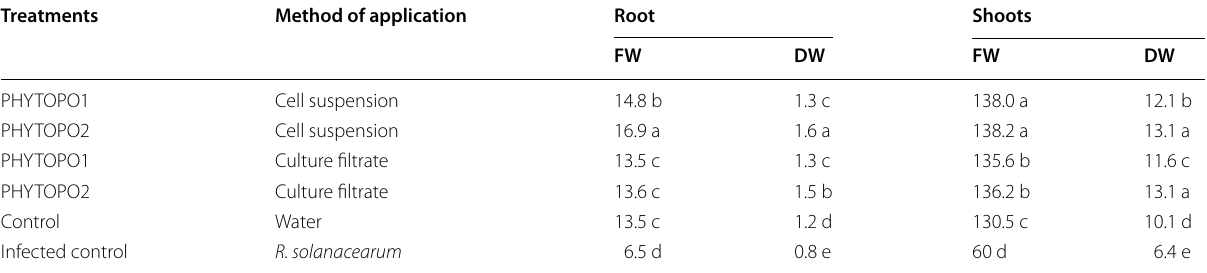
Table 3 Effect of some bacterial boiagents on fresh and dry weight of shoots and root under greenhouse conditions Treatments Method of